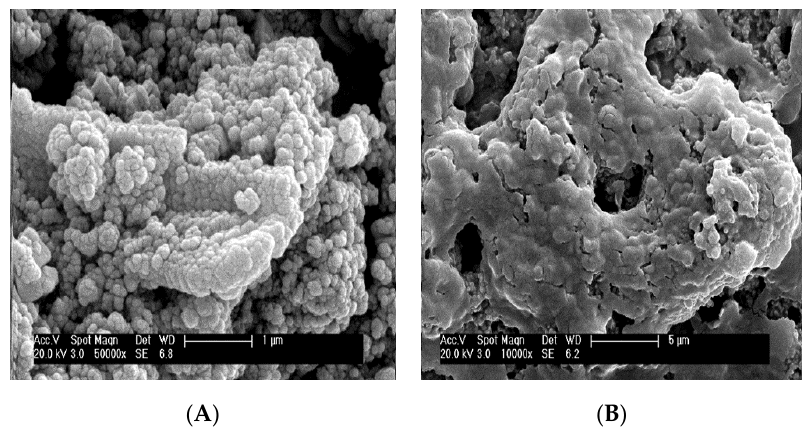
Figure 2. SEM images of ( A ) Fe 3 O 4 -PB film and ( B ) Glucose oxidase (GOD)-bovine serum albumin (BSA)/Fe 3 O 4 -PB film.